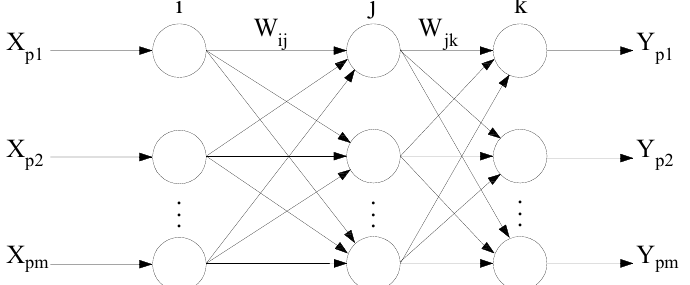
Figure 14. Topological structure of a three-layer back propagation (BP) neural network where X p1 , X p2 … X pm are the inputs of the neural network; Y p1 , Y p2 … Y pm are the outputs of the neural network; i, j, and k are the three layers; and W ij and W jk are the weights between the adjacent layers.